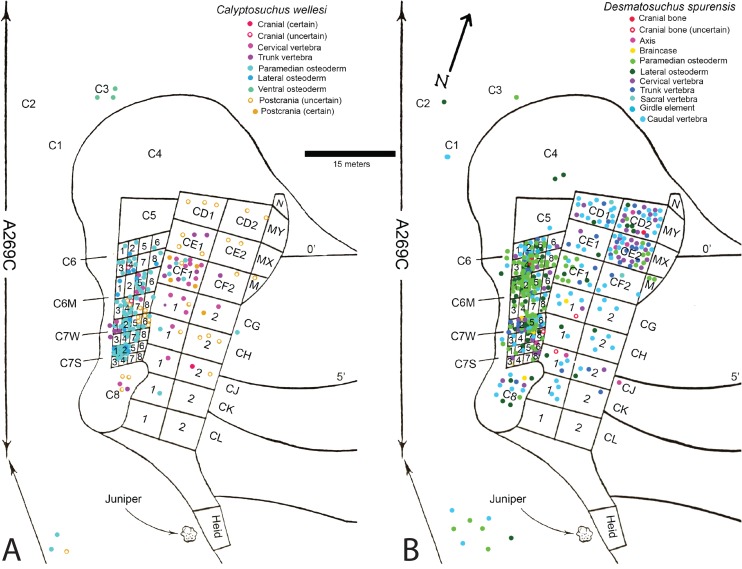
Aetosaur elements plotted on quarry map.Recovered elements of (A) Calyptosuchus wellesi and (B) Desmatosuchus spurensis plotted on the map of the Placerias Quarry. Map redrawn and modified from Camp & Welles (1956).